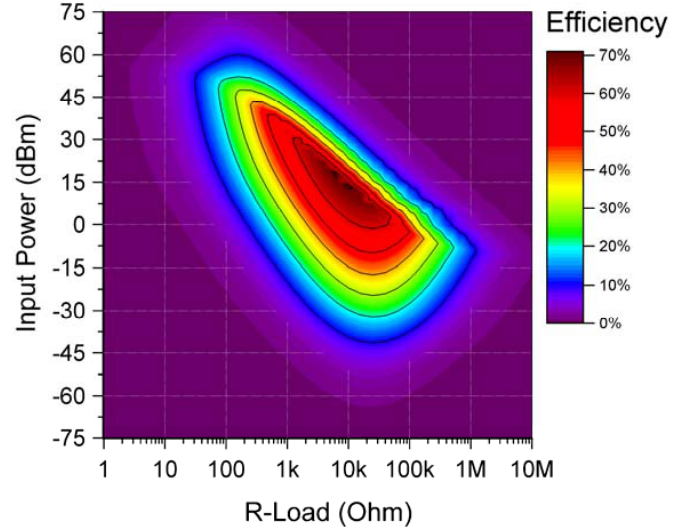
Figure 2. Representation of the simulated intrinsic efficiency function η rec ( P in , R L ) for N = 2 Dickson RF rectifier operating at 2.45 GHz.